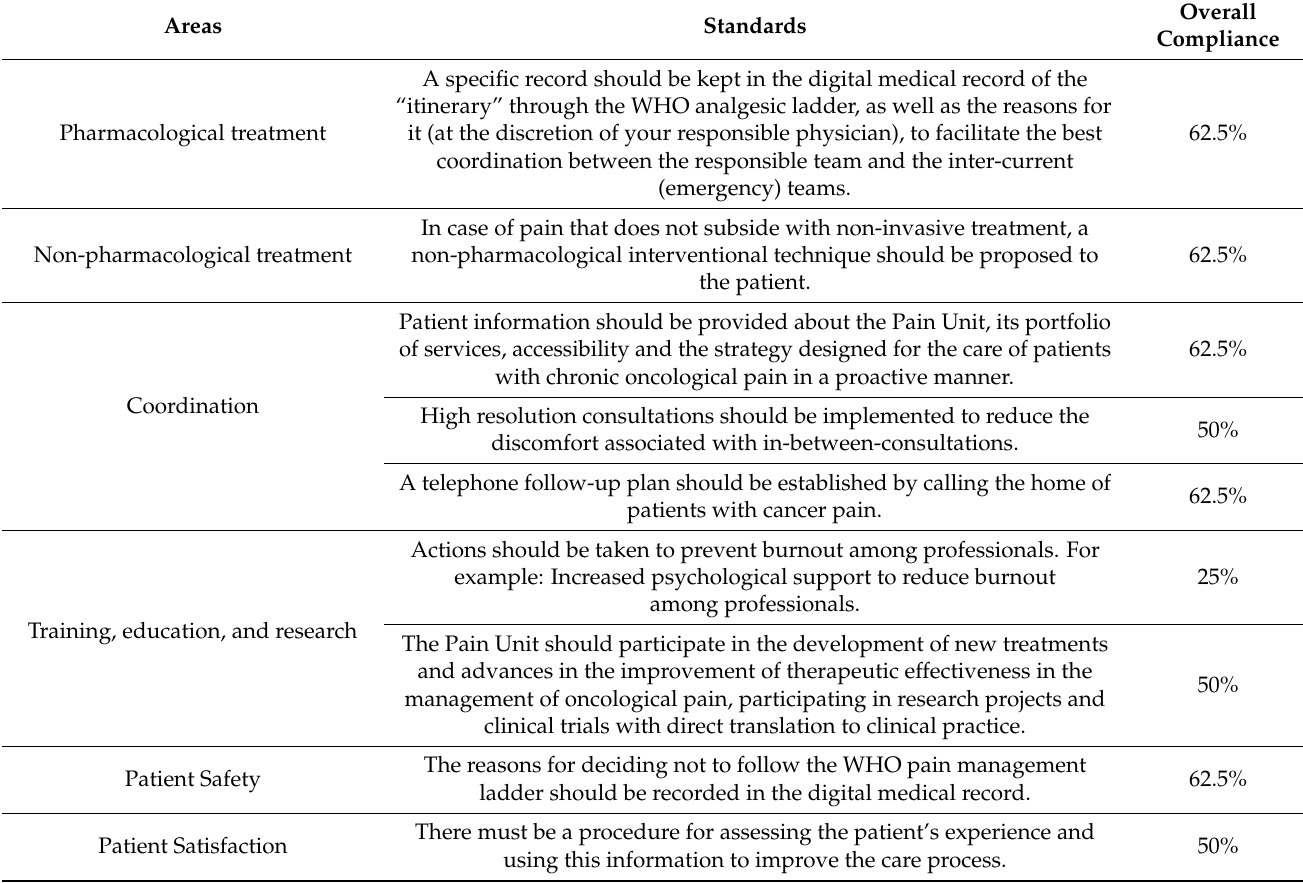
Table 4. Standards with least